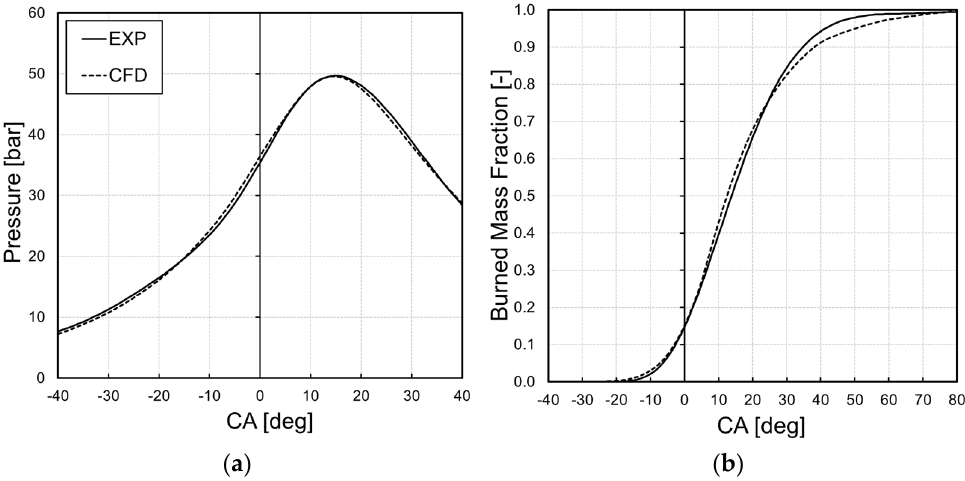
Figure 7. Validation of the numerical model at 4000 rpm: comparison between simulated and measured ( a ) in-cylinder pressure, ( b ) burned mass fraction.